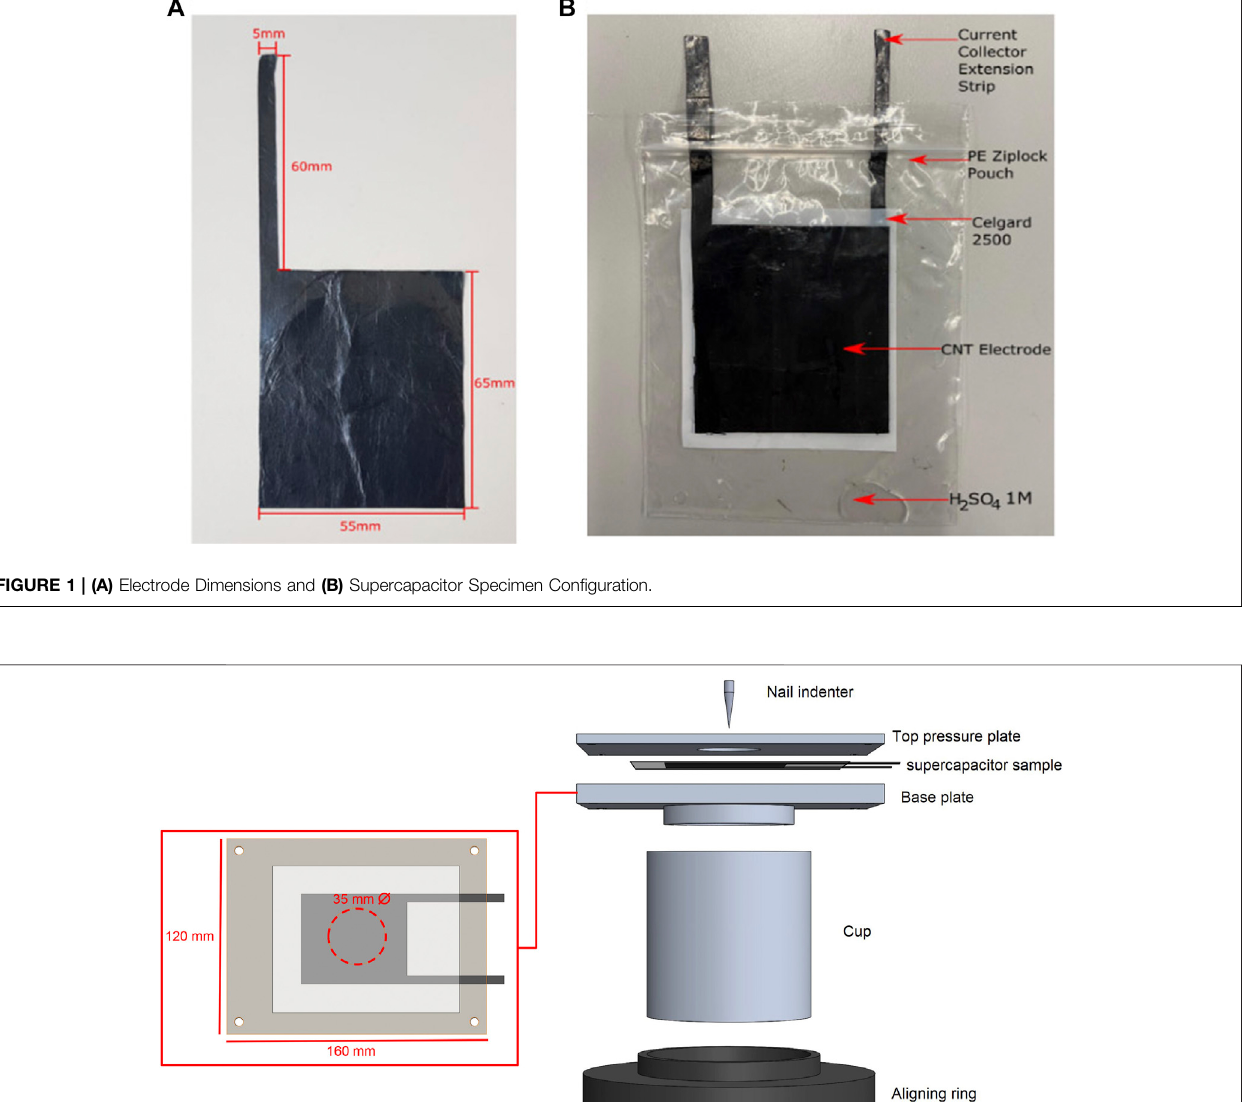
Frontiers in Materials |